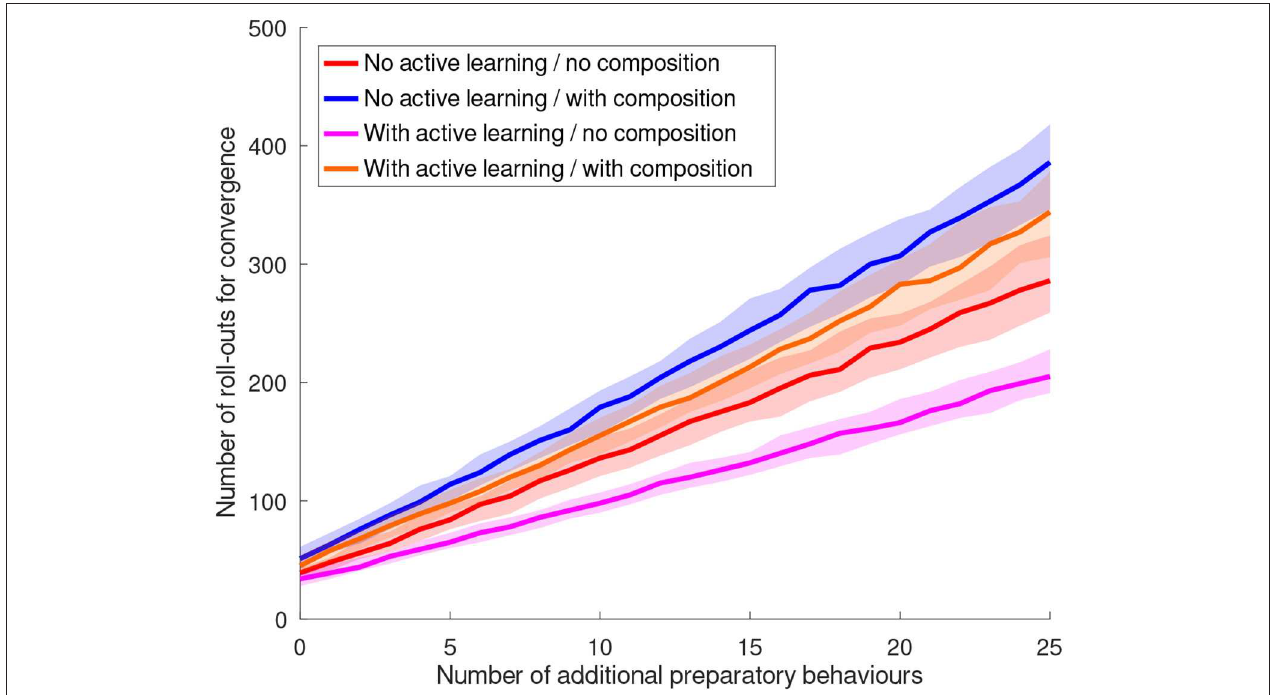
FIGURE 9 | Comparison of the convergence of the success rates between the original method and the extensions. The two curves with behavior composition solve a harder problem in which not all preparatory behaviors are available at the beginning. A linear fit k i x + d i was performed for all these curves (not shown) with the coefficients ( k 1 , d 1 ) = (10,36) (no active learning, no behavior composition), ( k 2 , d 2 ) = (7,31) (with active learning, no behavior composition), ( k 3 , d 3 ) = (13,46) (no active learning, with behavior composition), and ( k 4 , d 4 ) = (12,40) (with active learning, with behavior composition).